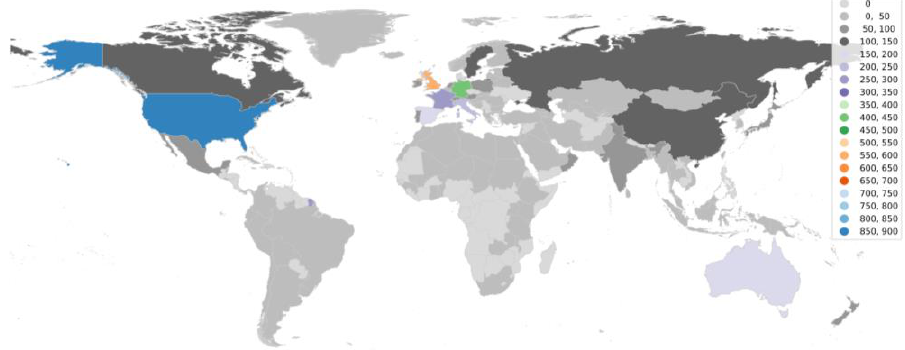
Figure 3. World map showing aDNA human-based research publications around the globe.